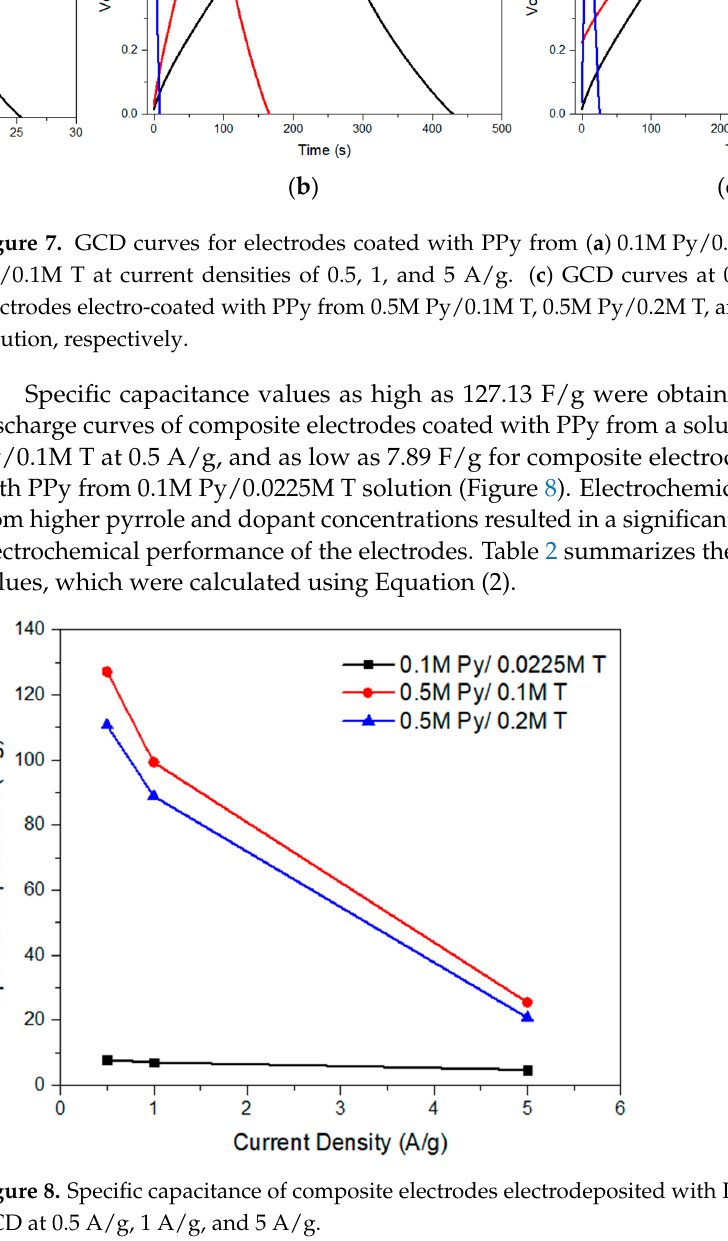
tance retention of over 100% and was observed to increase its retention up to 120% at longer cycles. Electrodes formed from lower concentrations of Py seem to show lower retention over the same duration. Table 2. Summary of specific capacitance obtained from charge–discharge cycles at 0.5, 1, and 5 A/g. Specific Capacitance ( F/g ) 600 s Deposition on 50 wt% SWCNT/PI Electrodes 0.5 A/g